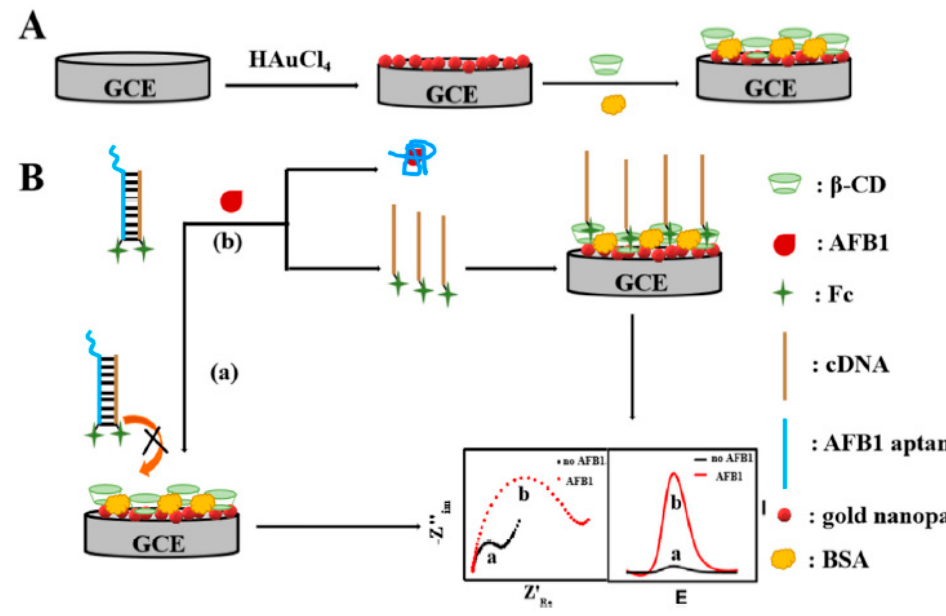
Figure 1. A schema of the construction process of electrochemical aptasensor for AFB1 ( A ) and its detection approach ( B ). Reprinted with permission from [14]. Copyright 2019, Elsevier.